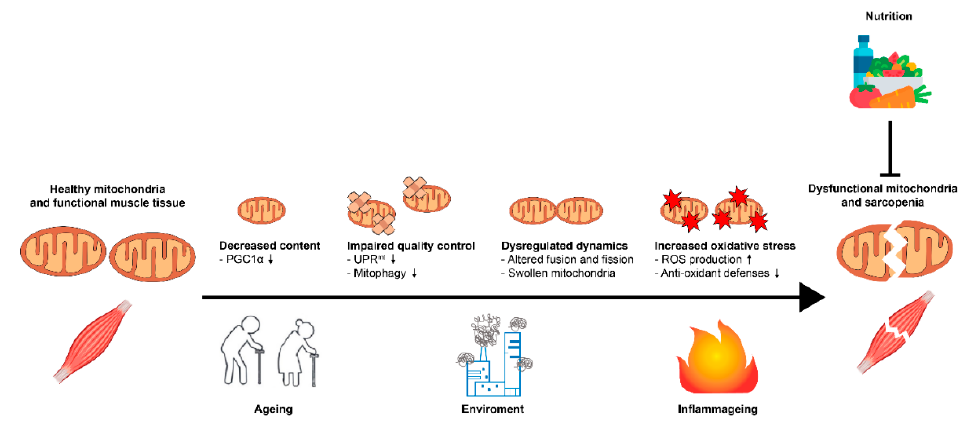
Figure 2. The relationship between mitochondrial dysfunction, oxidative stress, inflammageing, malnutrition, and sarcopenia. ↓ : decreased; ↑ : increased. malnutrition, and sarcopenia. ↓ : decreased; ↑ :